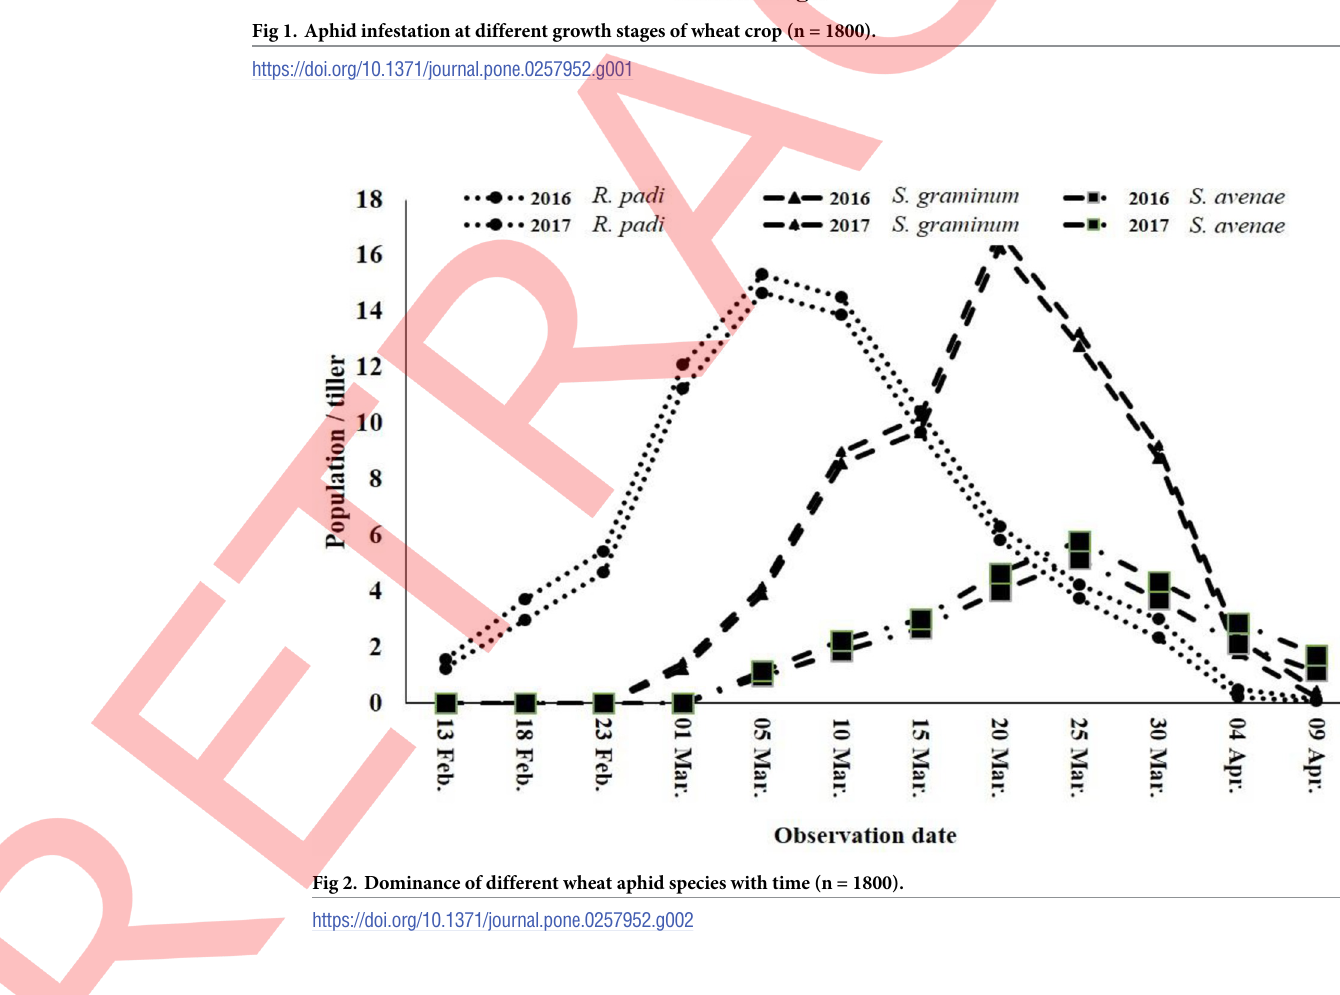
PLOS ONE | https://doi.org/10.1371/journal.pone.0257952 October 13,